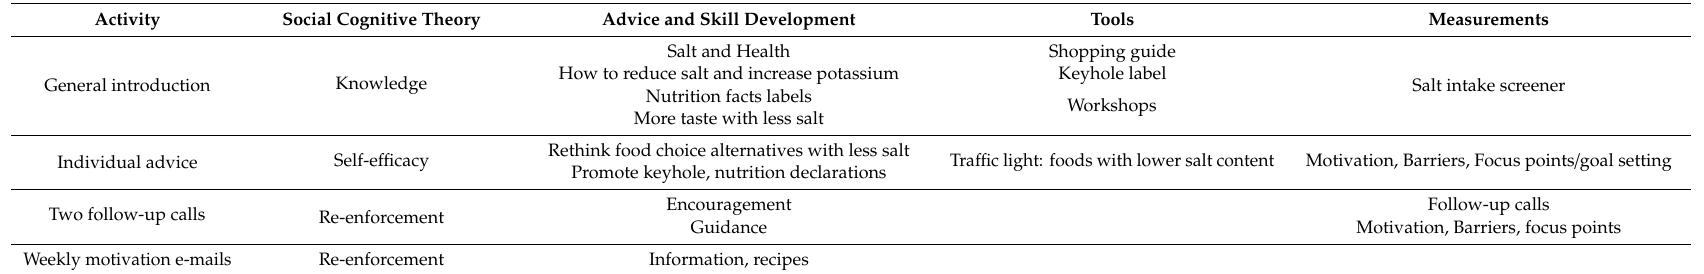
Table 2. Application of theory on salt reduction to dietary